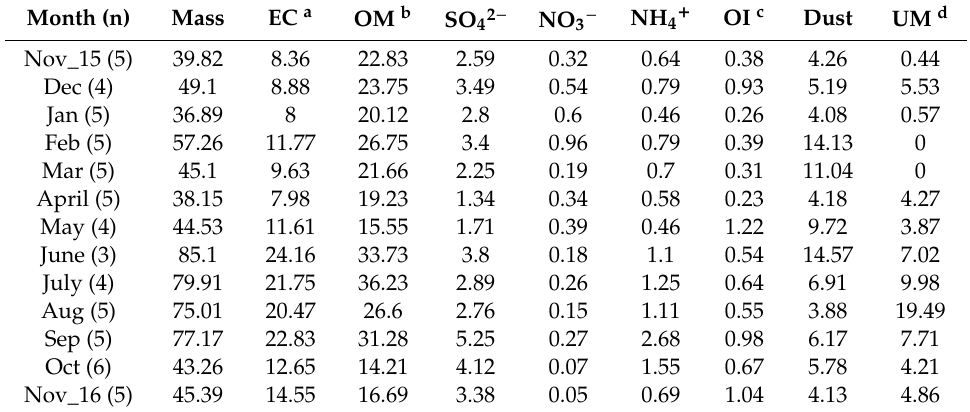
Table 1. Monthly average concentration of PM 2.5 and bulk composition in Addis Ababa (μg/m 3 ), Nov.